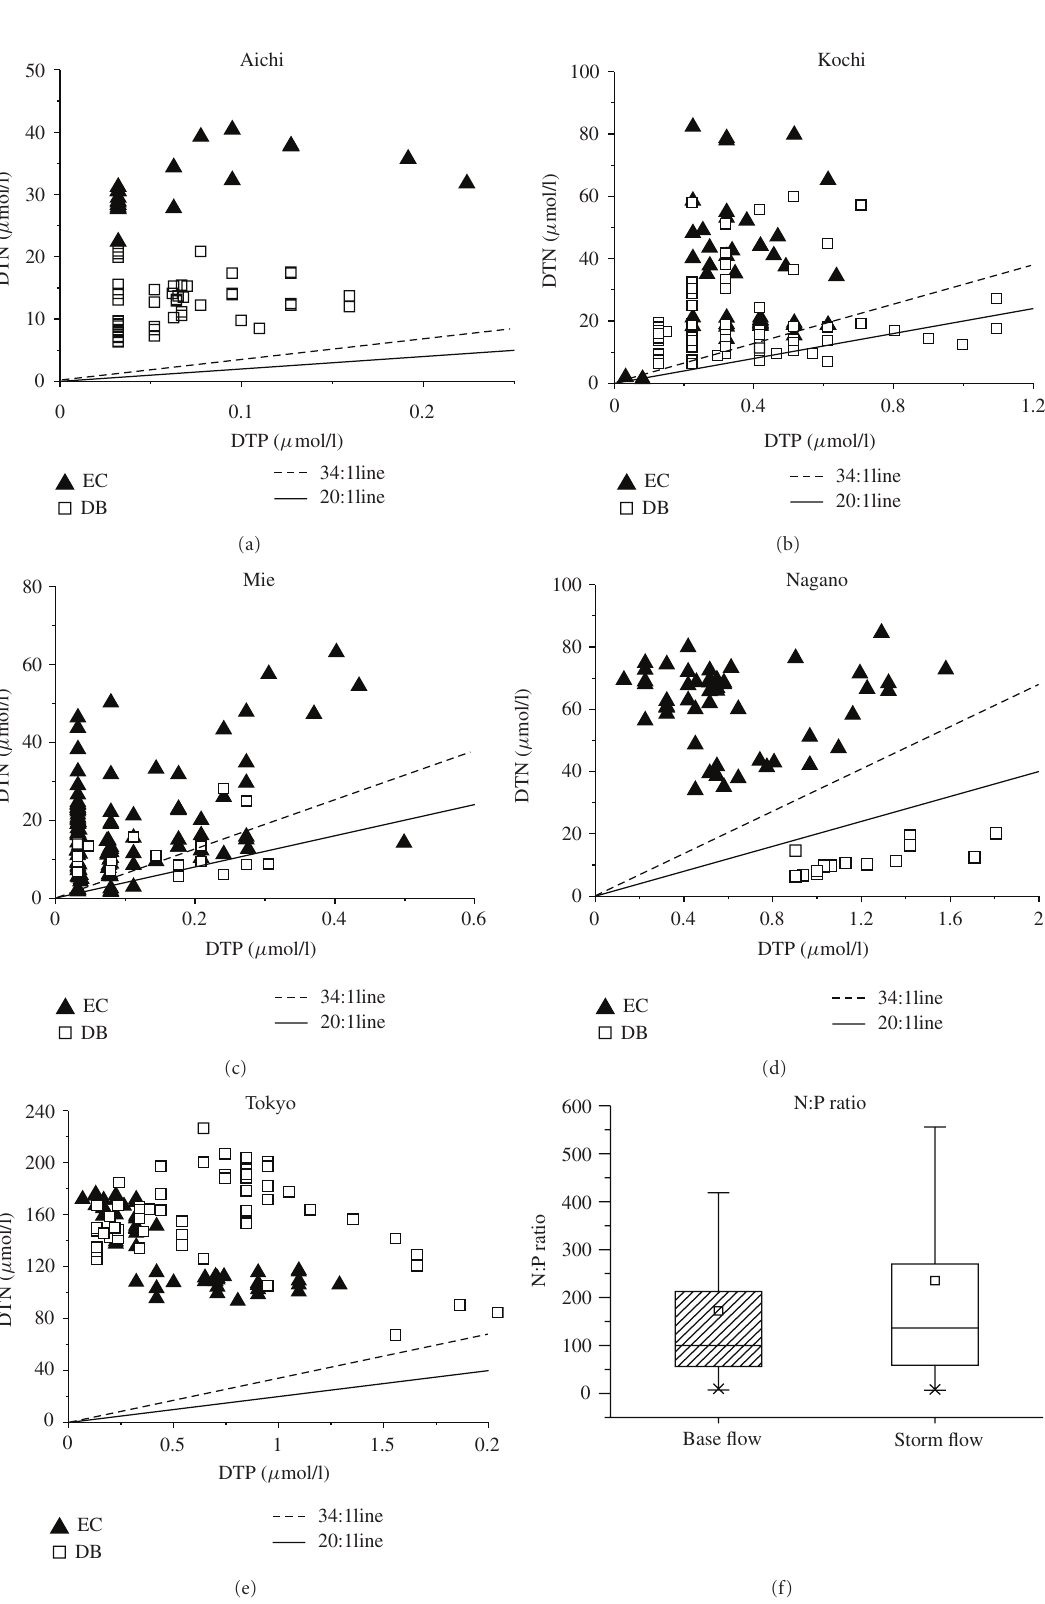
Figure 2: Relationships between the runo ff concentrations of DTN and DTP in the EC and DB forests during storm events in each